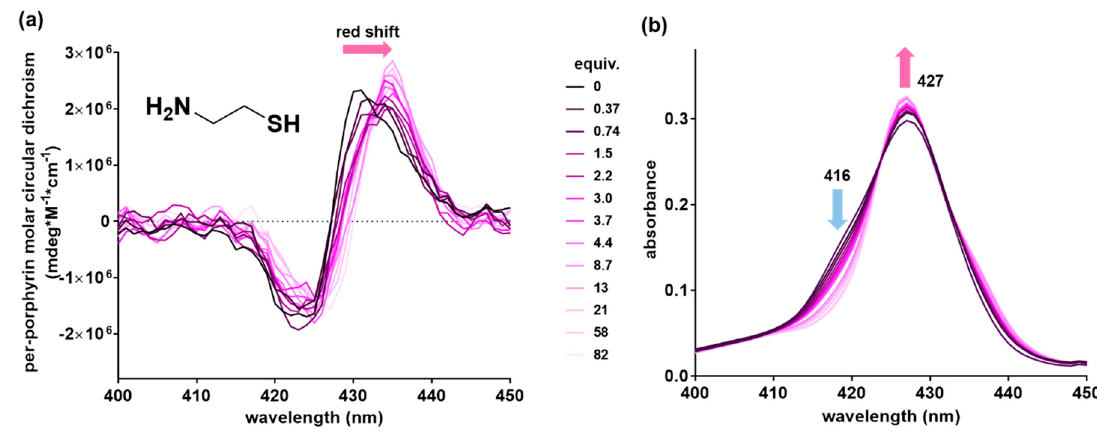
Figure 5. Titration of 2 (0.27 μ M) with cysteamine in CH 2 Cl 2 at 20 °C monitored by ( a ) CD and ( b ) UV-vis spectroscopy.